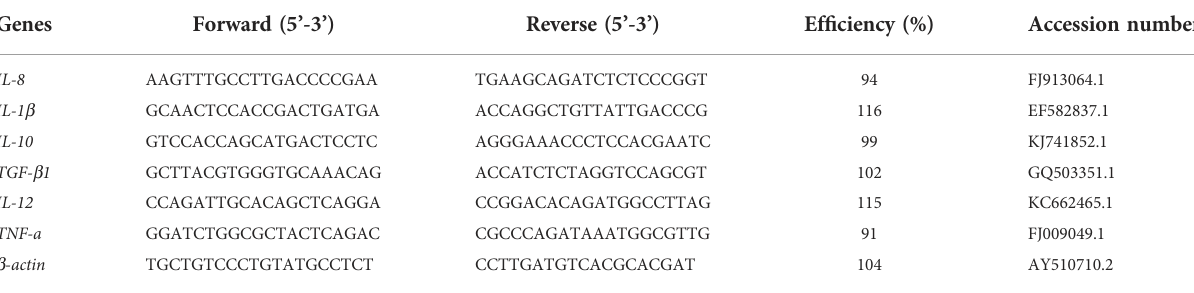
TABLE 2 Primer sequences for real-time PCR